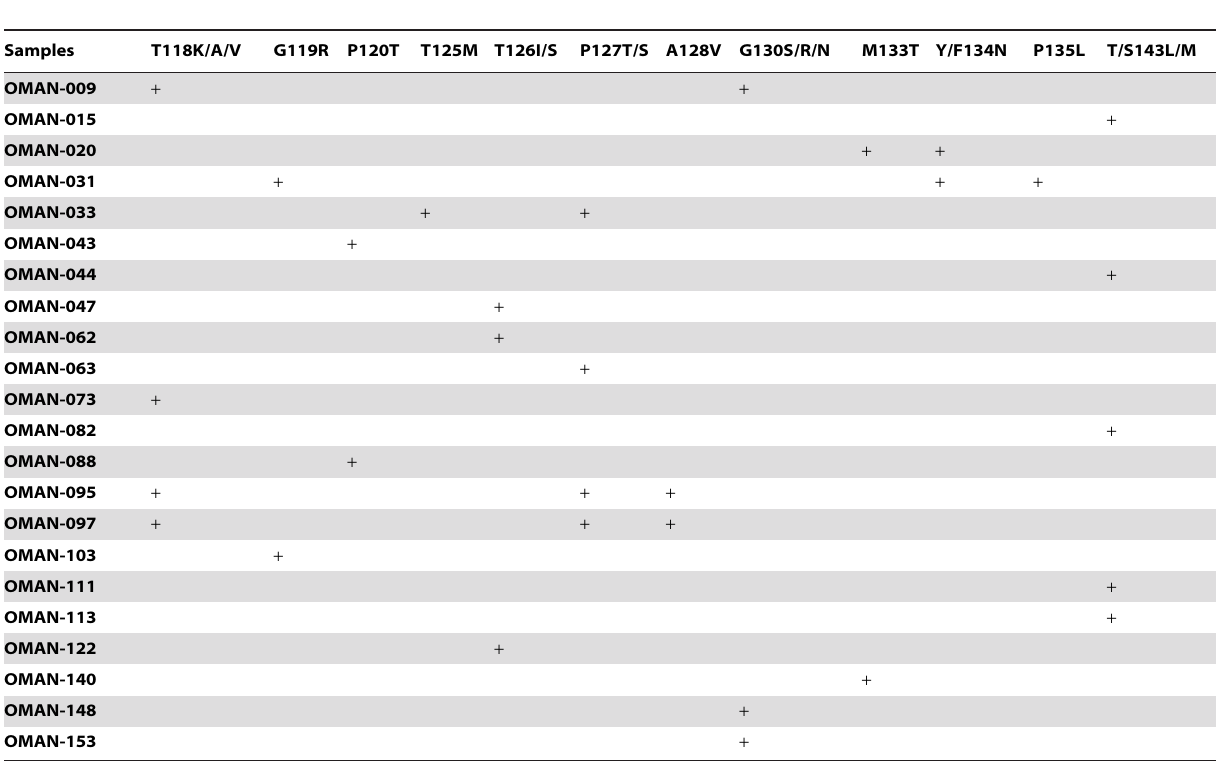
Table 3. Mutations in the ‘‘a’’ determinant domain of Omani HBV isolates.